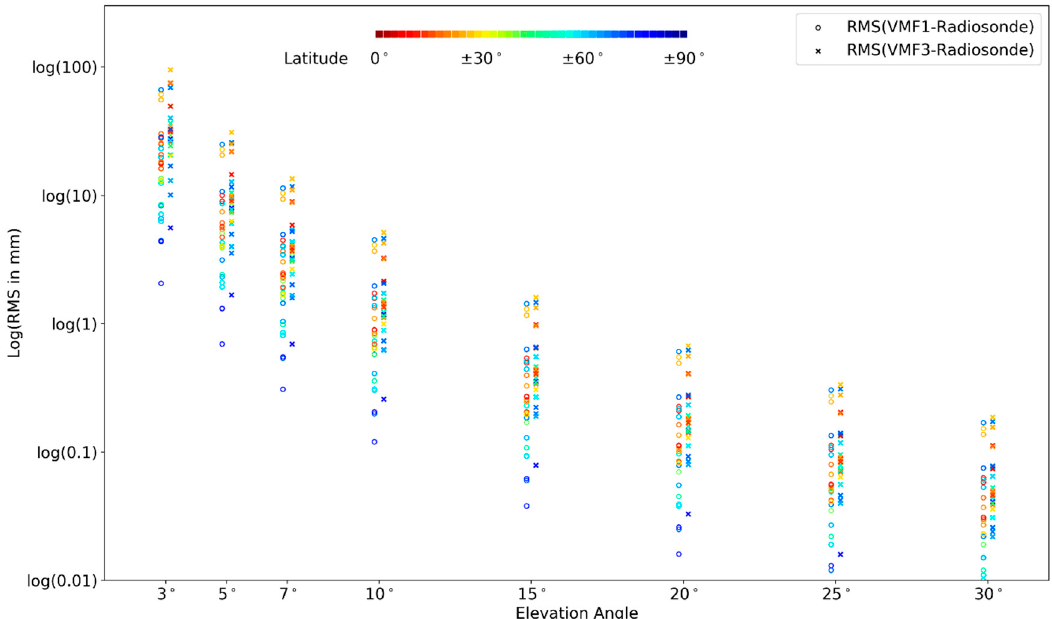
Table 6. Mean RMS, bias, and standard deviation for 28 stations, 3 years of wet VMF1 and VMF3 compared to radiosonde in mm. Figure 12. RMS of VMF1 / VMF3 SWD estimates with reference to radiosonde SWD estimates from ray-tracing in mm. Cross marks stand for VMF3 estimates, and circle marks stand for VMF1 estimates (they are plotted with a small horizontal shift to avoid overlapping), for the 28 stations of this study, over a 3-year period (1 January 2016 to 31 December 2018). The color bar indicates the station latitudes.